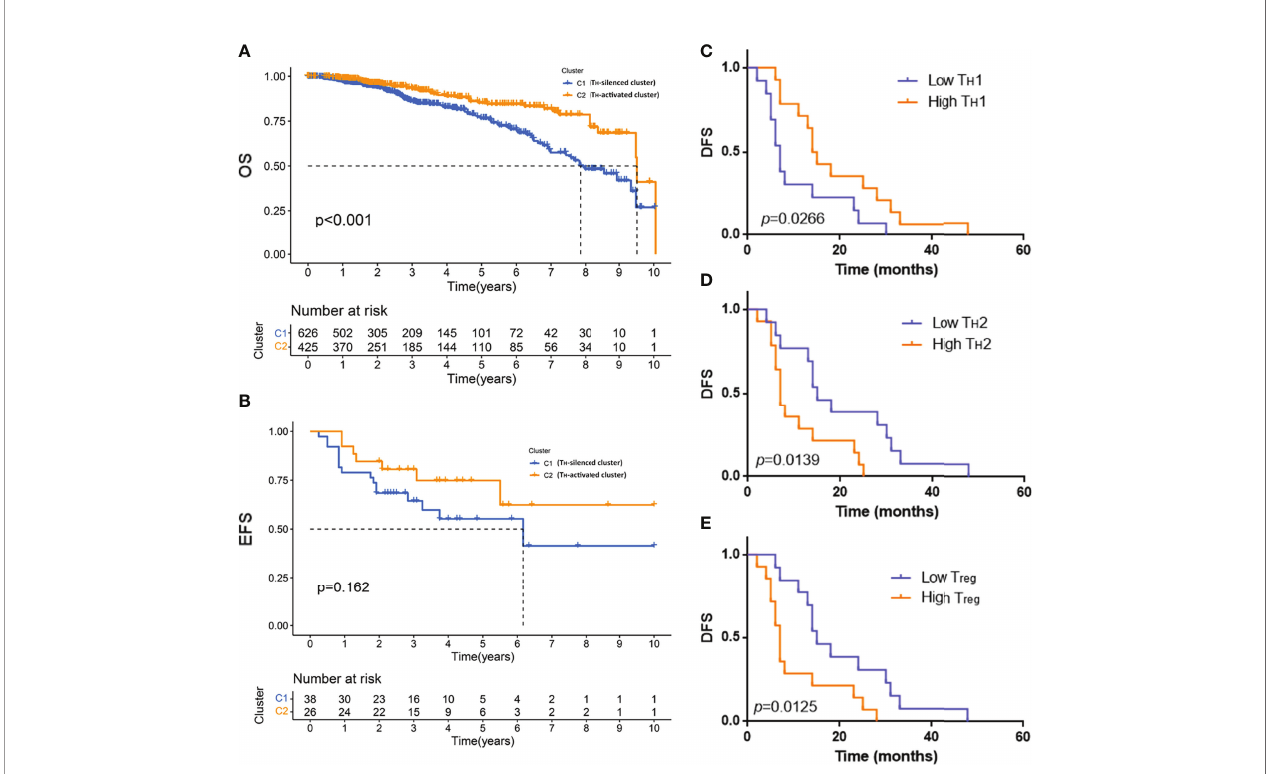
FIGURE 5 | The prognosis of the T H -activated cluster and T H -silenced cluster in breast cancer and the prognosis of different groups based on T H cell subtypes. Kaplan – Meier (K – M) survival analysis was employed for 10-year overall survival (OS) of 1,090 samples from the TCGA database (A) and the 10-year event-free survival (EFS) of 64 TNBC samples from the GSE31519 dataset (B) . K – M survival curve of disease-free survival (DFS) of 30 TNBC samples grouped by low or high tumor-in fi ltrating